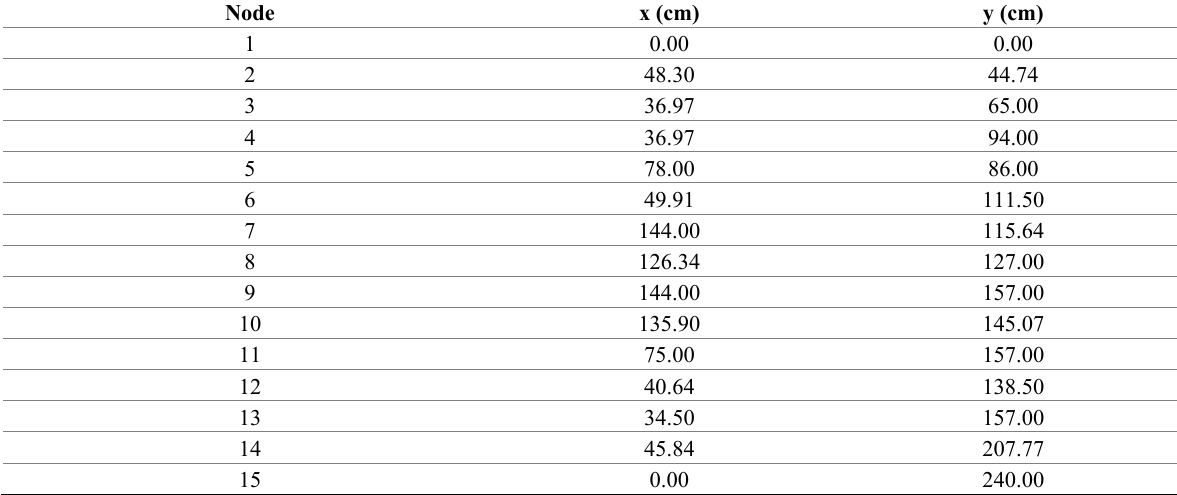
Table 7. Coordinates of truss model for f = 40% Node x (cm)